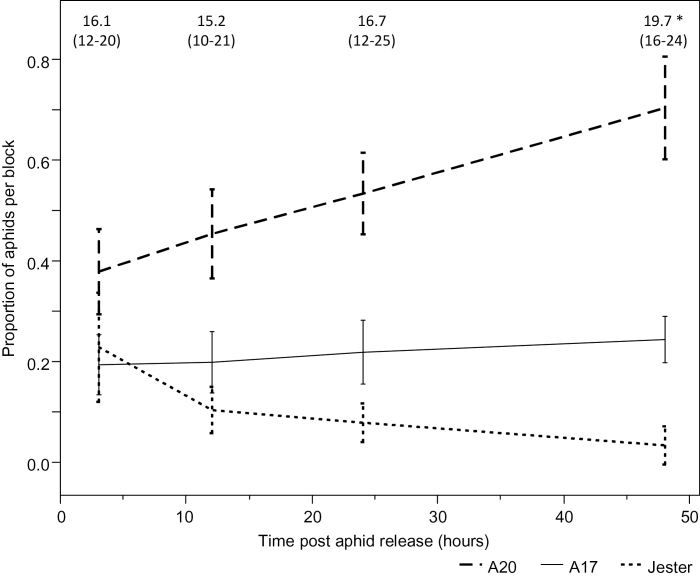
The settling of SAA alatae in a host choice experiment on M. truncatula accessions. Error bars are 95% confidence intervals of the mean (n=10). The mean (minimum–maximum) number of aphids per block is indicated.